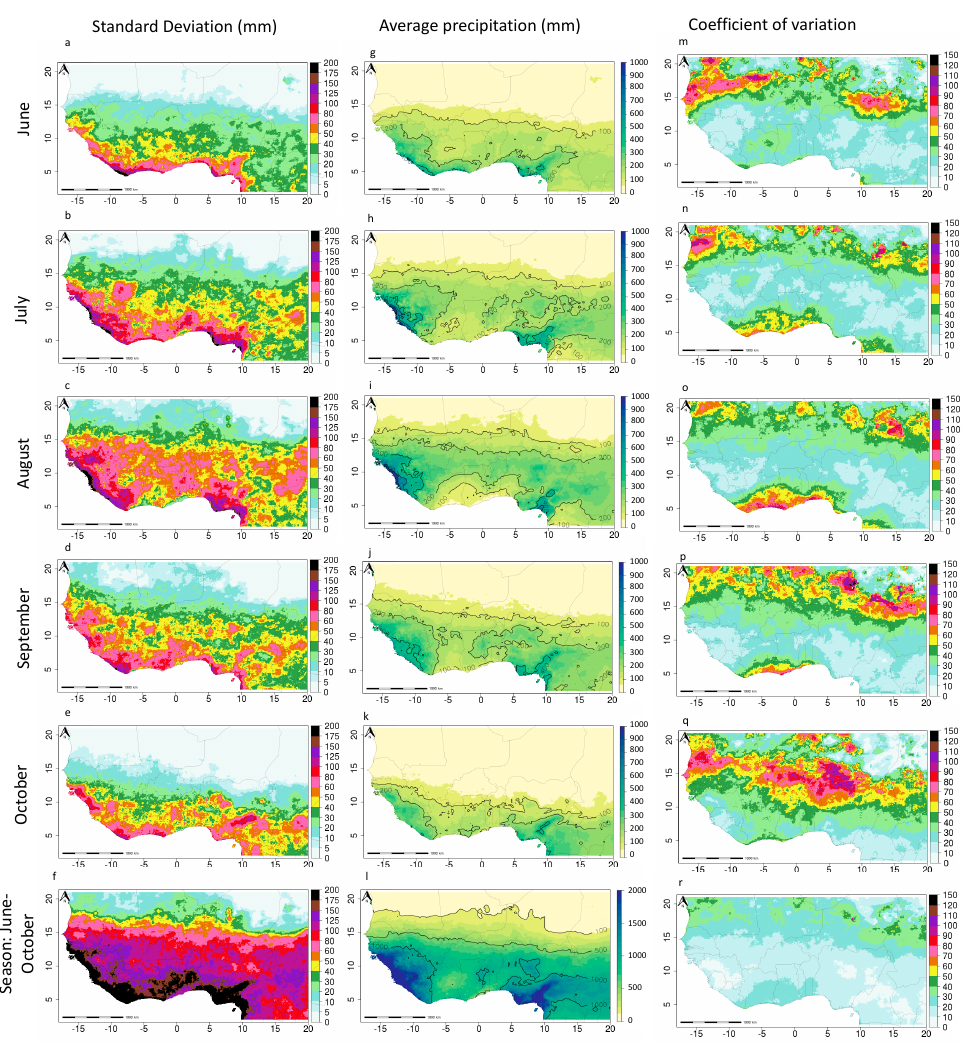
Figure A1. These three columns show the variability for precipitation from 1981 to 2016. The right-hand column ( a – f ) has the standard deviation by month expressed in mm/month (mm/season for ( f ), June ( a ), July ( b ), August ( c ), September ( d ), October ( e ), and the whole season ( f ) for 1981–2016. The middle column ( g – l )shows the average precipitation per month (expressed in mm/month or mm/season for ( l )) for June ( g ), July ( h ), August ( i ), September ( j ), October ( k ), and the whole season ( l ). The left-hand column ( m – r ) has the coefficient of variation per month expressed in percentage for June ( m ), July ( n ), August ( o ), September ( p ), October ( q ), and the whole year ( r